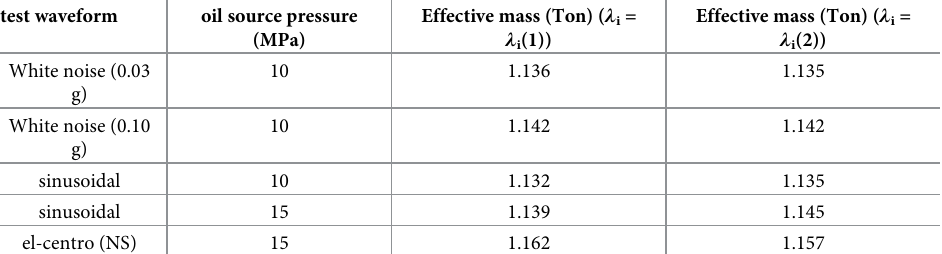
Table 3. Effective quality system ( α = 0.5).